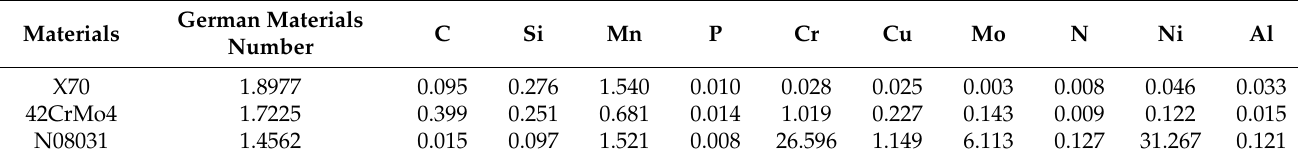
Table 1. Chemical composition with major elements 1 as the weight percent of the investigated material.